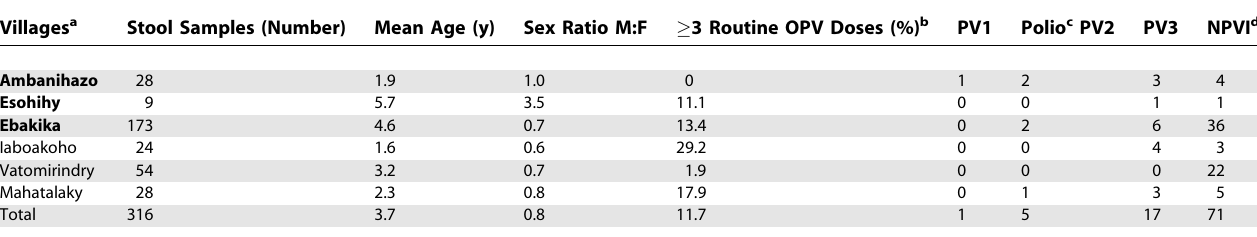
Table 4. Epidemiological and Virological Data for the Healthy Children Villages a Stool Samples